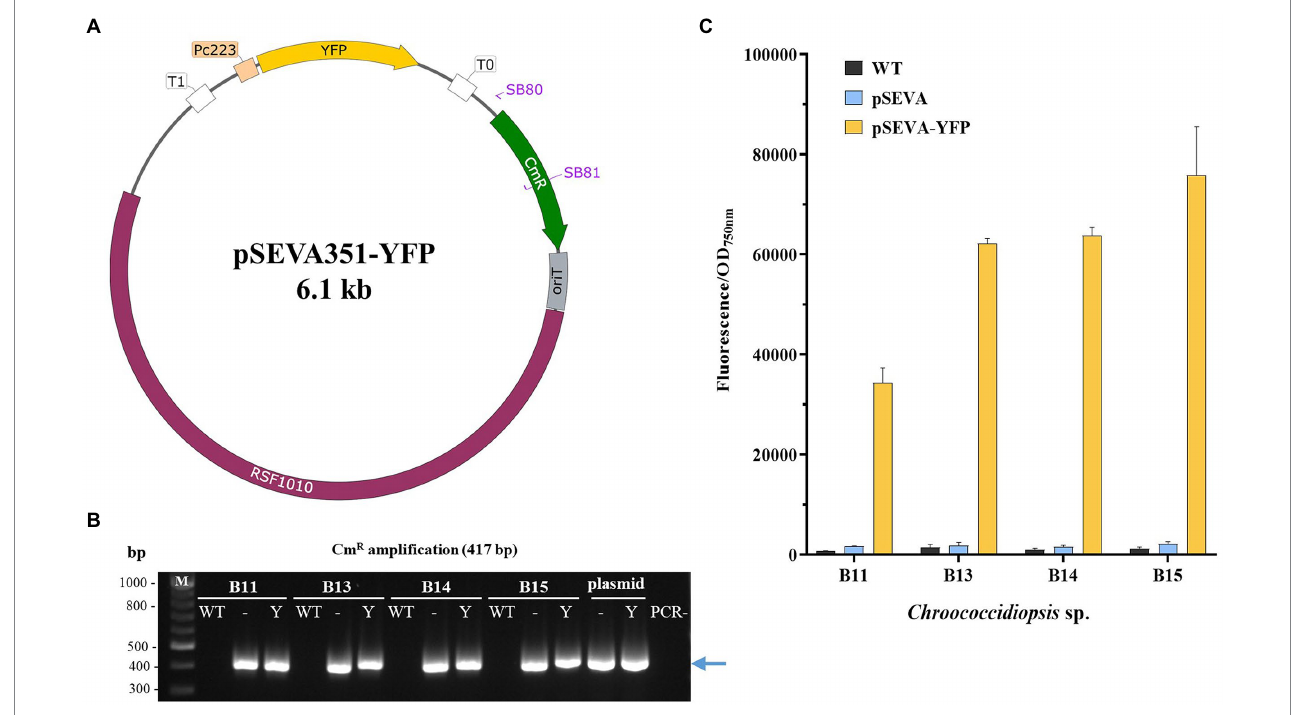
FIGURE 9 Construction and evaluation of the pSEVA351-YFP as an expression vector in Chroococcidiopsis sp. Helios. (A) Map of the pSEVA351 carrying the YFP reporter under the promoter P c223 (pSEVA351-YFP). (B) PCR confirmation of positive transformants of 7-day cultures. Specific primers SB80/81 amplifying chloramphenicol resistance gene were used for verification– pSEVA351 (empty plasmid); Y: pSEVA351-YFP; M: DNA marker (kb); PCR-: negative control (no DNA). (C) Fluorescence measurements of Chroococcidiopsis sp. Helios transformed with pSEVA351-YFP. As a control, WT and Helios isolates harboring pSEVA351 are shown. Relative YFP fluorescence in relation to OD 750nm was quantified. The graph shows the average of three biological replicates together with the standard